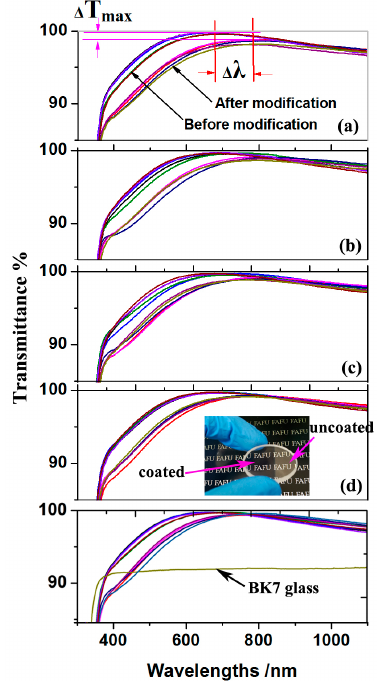
Figure 6. Transmittance spectra of ARCs before and after being modified by F-PMHS in different